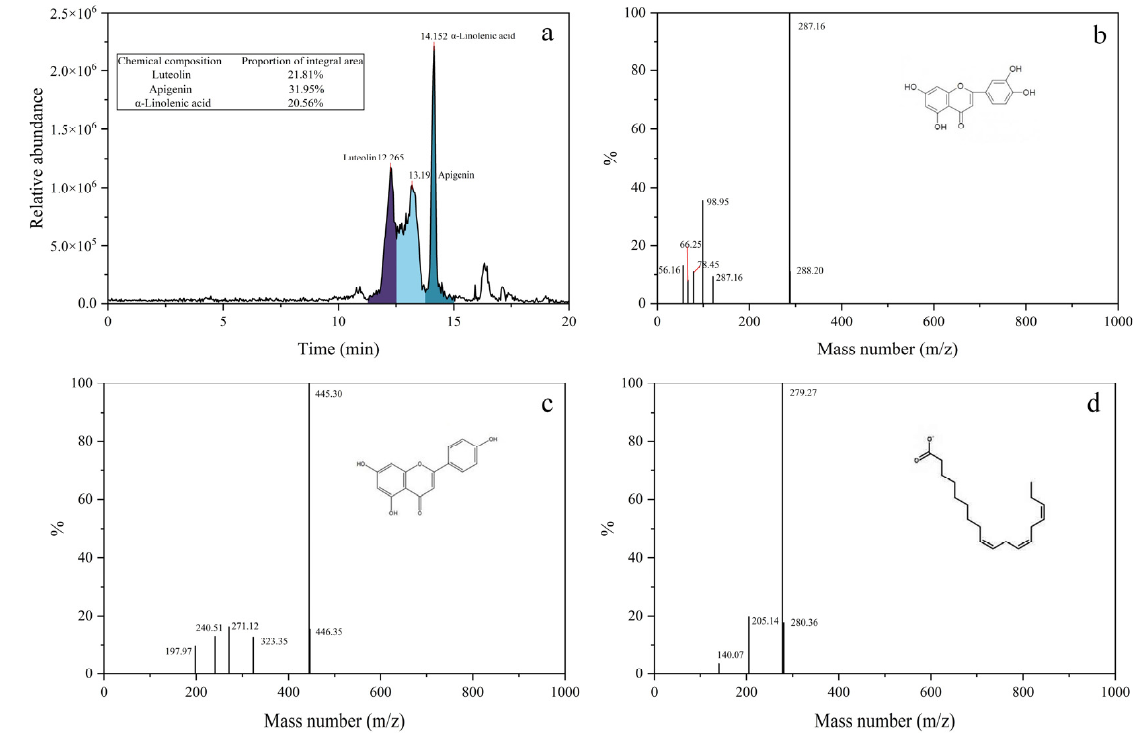
Figure 5. Perilla seed extract’s ( a ) chromatography and mass spectrometry: ( b ) luteolin, ( c ) apigenin and ( d ) α -linolenic acid.